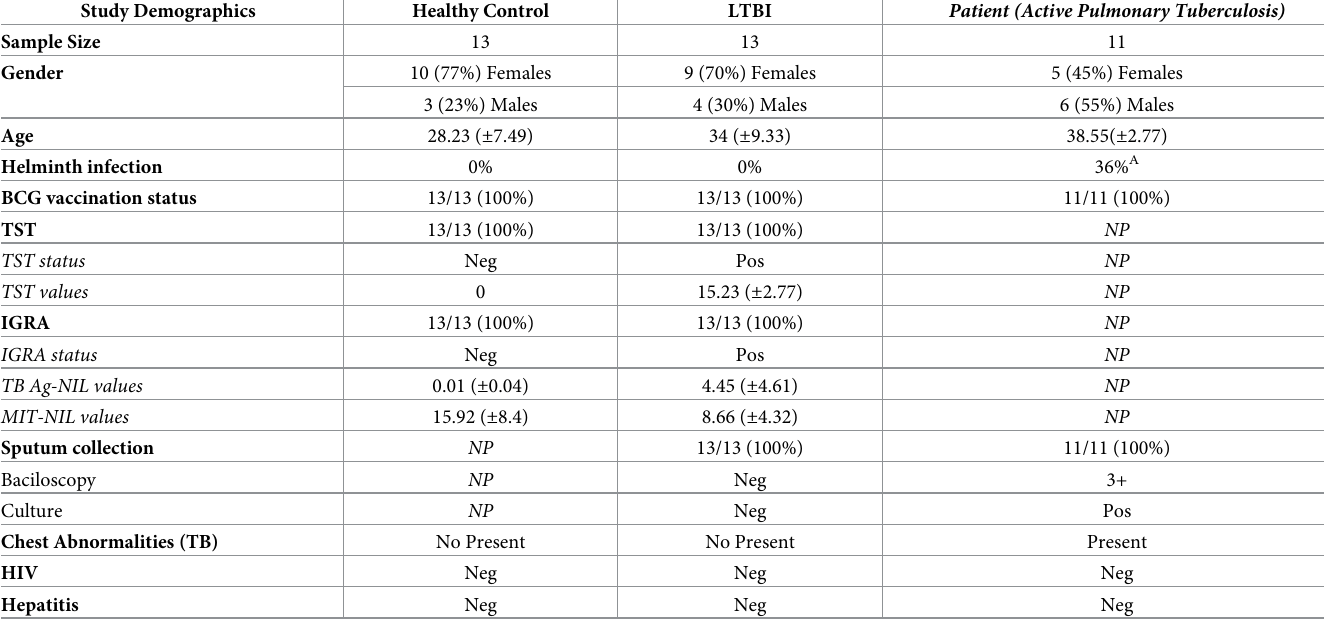
Table 2. Description of all participants of the study.